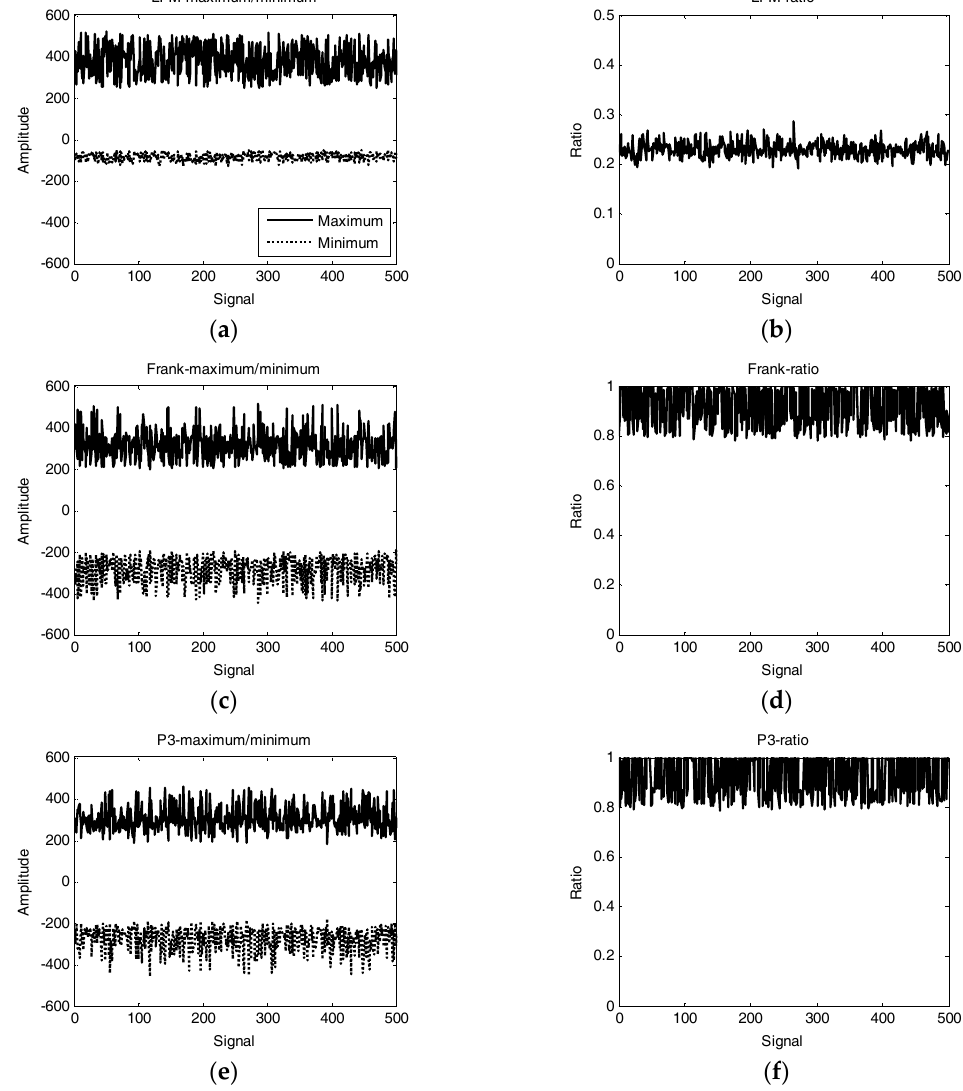
Figure 4. In this figure, ( a ), ( c ) and ( e ) are the minimum and minimum values of Wigner-Ville distribution (WVD) of linear frequency modulation (LFM), Frank and P3 at signal to noise ratio (SNR) = 6 dB, respectively. ( b ), ( d ) and ( f ) are the absolute of the ratio of minimum to maximum of LFM, Frank and P3, respectively. There are 500 signals of each waveform.